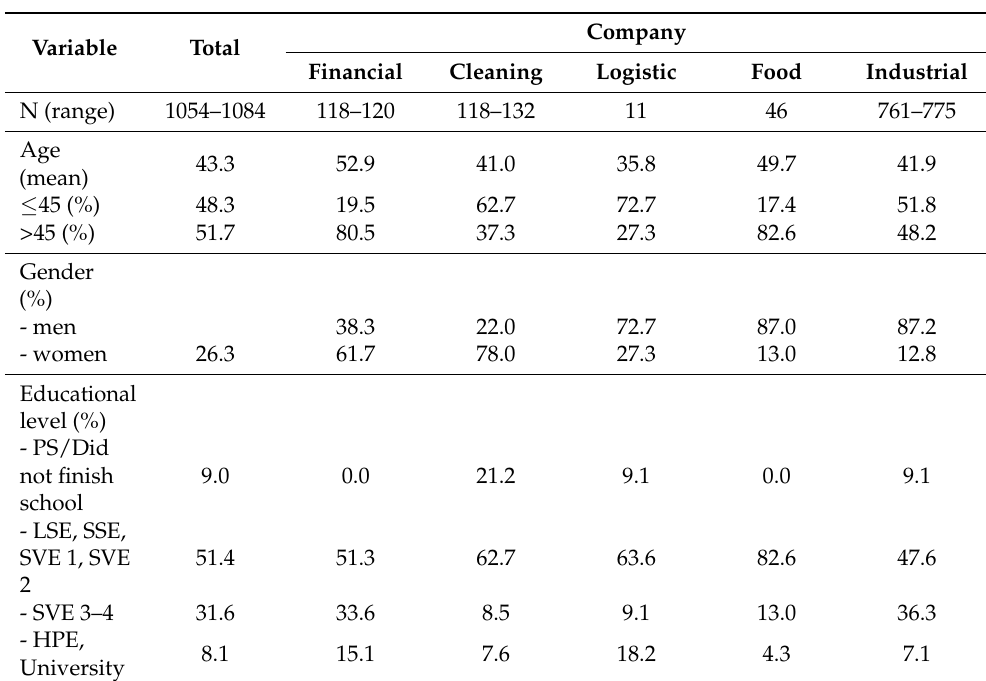
Table 1. Sample characteristics: number of employees, age (mean and %), gender (%) and educational level (%).